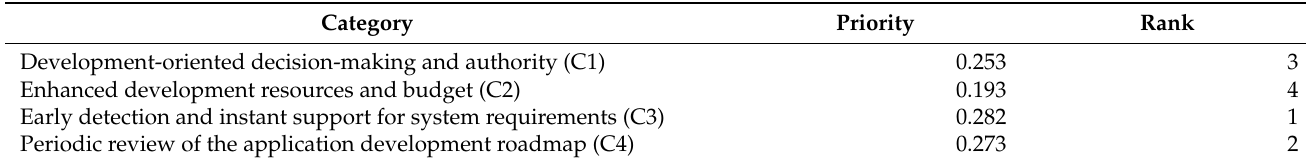
Table 9. Consolidated priorities for D1 sub-criteria.